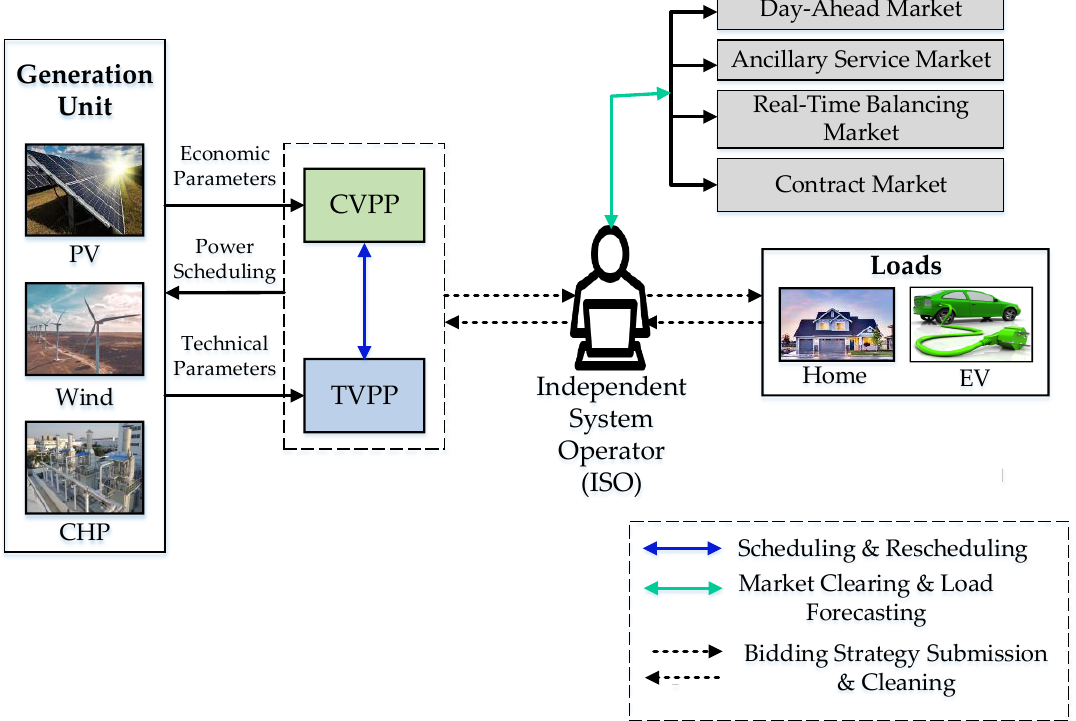
Figure 4. A basic framework of virtual power plant consisting of distributed energy resources. (Note: PV-photovoltaics; CHP-combined heat and power; CVPP-commercial virtual power plant; TVPP-technical virtual power plant; EV-electric vehicle).